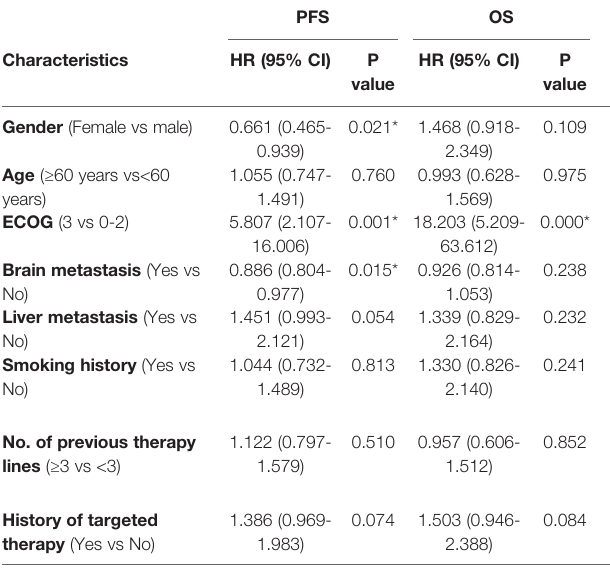
TABLE 5 | Univariate analysis of PFS and OS (COX regression analysis).